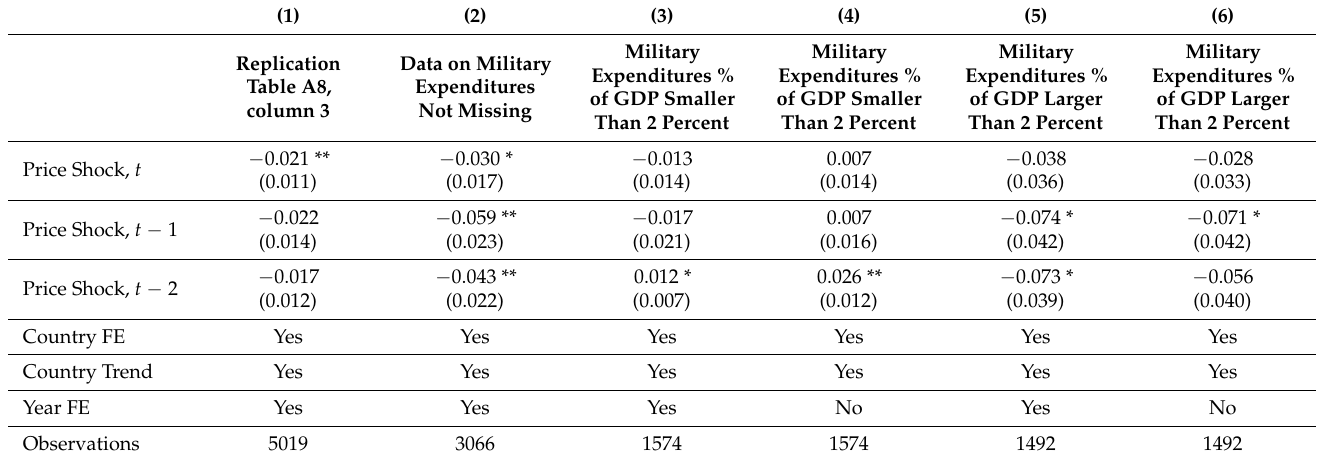
Table A4. Ciccone (2019). “International Commodity Prices and Civil War Outbreak: New Evidence for Sub-Saharan Africa and